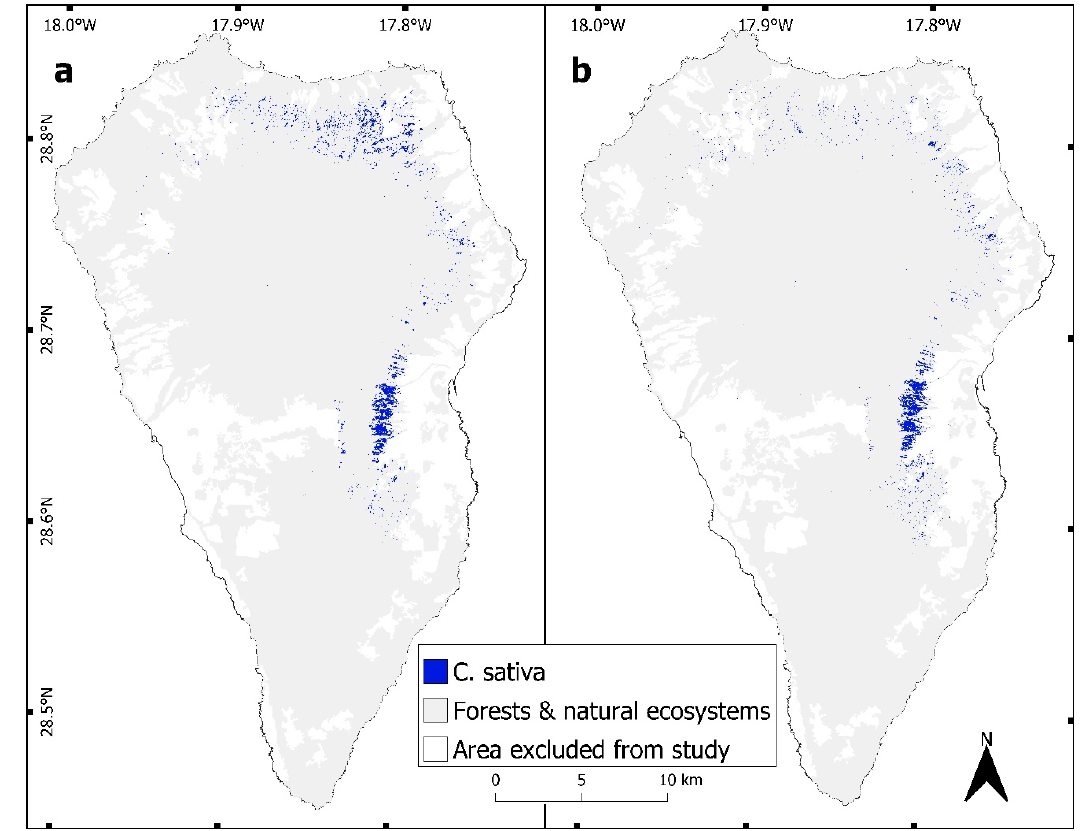
Figure 4. C. sativa spatial coverage (blue) detected on ( a ) the Landsat 8 image and ( b ) Sentinel-2 image obtained from the Random Forest (RF) classifications. The classifications were carried out on the images obtained from the image regression and differentiation. ‘Forests and natural ecosystems’ (grey shading) are land cover not related to direct human land use. Settlement and agriculture (areas used for direct human purposes, including roads, buildings, agricultural lands, etc.) were cropped out and not included in the analysis.